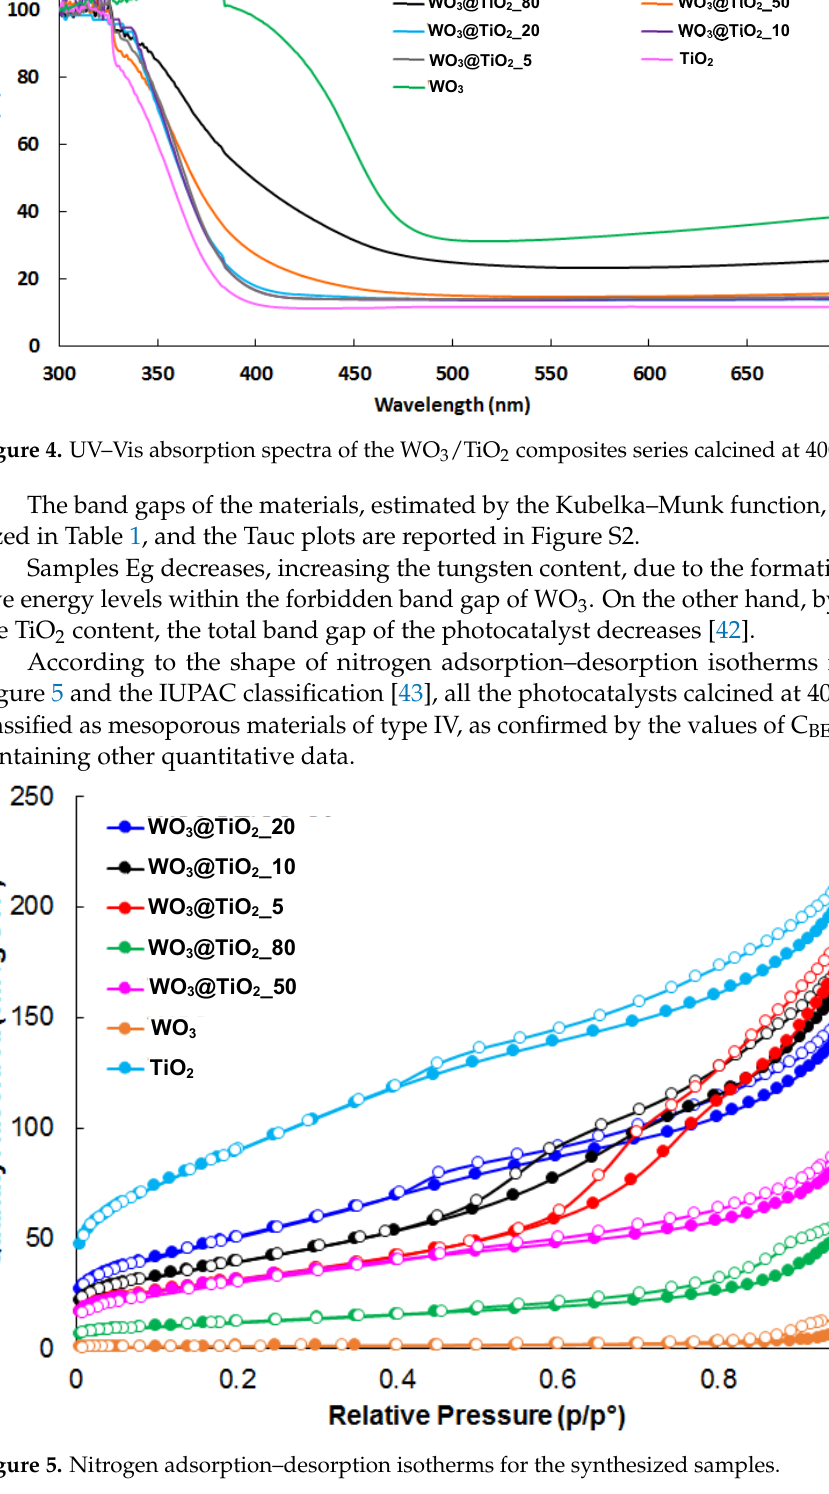
Figure 5. Nitrogen adsorption–desorption isotherms for the synthesized samples.